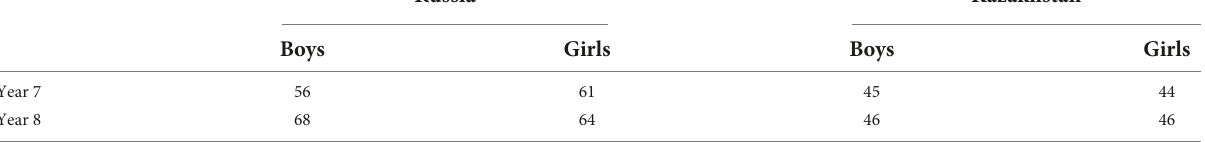
TABLE 1 Research sample